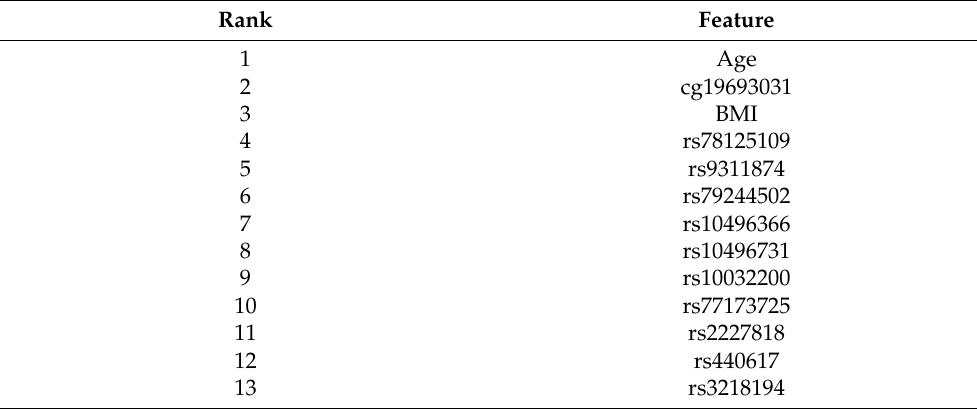
Table 13. Top ranked important features selected by a BRF for predicting normoglycemic vs. dia- betic